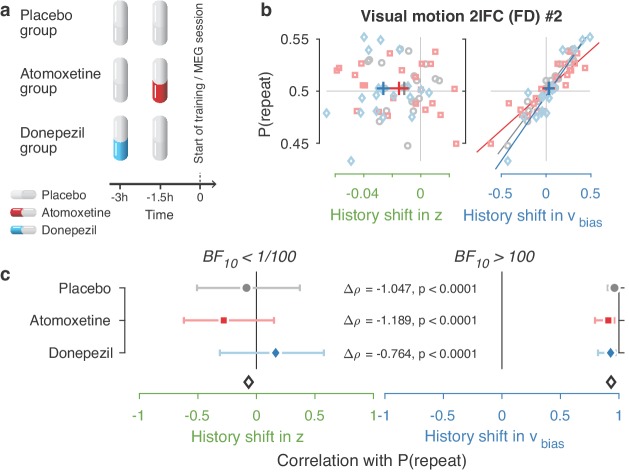
Control model fits.(a) Summary figure based on non-hierarchical G2 fits (Ratcliff and Tuerlinckx, 2002). Rather than the full RT distribution, we fit each observers’ RT quantiles (0.1, 0.3, 0.5, 0.7, 0.9) and correlated history shifts in the DDM bias parameters to individual P(repeat), as in Figure 4. (b) Summary figure based on the full hierarchical model, where across-trial variability in non-decision time (st) was added as a free parameter. Like the across-trial variability in drift rate (sv) and starting point (sz), the st parameter was only estimated at the group level (Ratcliff and Childers, 2015). (c) Fits of the two datasets with multiple evidence strengths, allowing non-decision time to vary with these discrete levels (see Materials and methods). (i) Posterior distributions of group-level non-decision time for each level of evidence strength. (ii) Comparison between models accounting for choice history bias through a starting point, drift bias or both, while allowing for non-decision time to vary with levels of stimulus strength. (iii) Correlations between individual history shifts in starting point or drift bias and repetition probability, from a model where non-decision time was separately estimated per level of stimulus strength.